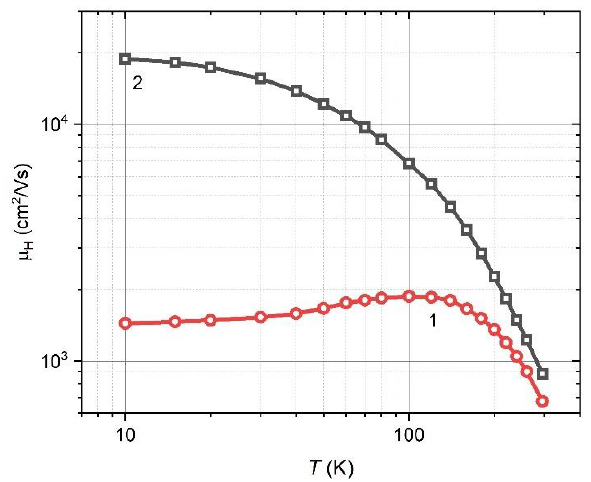
Figure 7. Experimentally obtained temperature dependence Pb 0.995 In 0.005 Te of 3µm thickness ( T S = 623 K). Numbers correspond to Hall mobility µ H : before — 1 and after — 2 heat treatment.